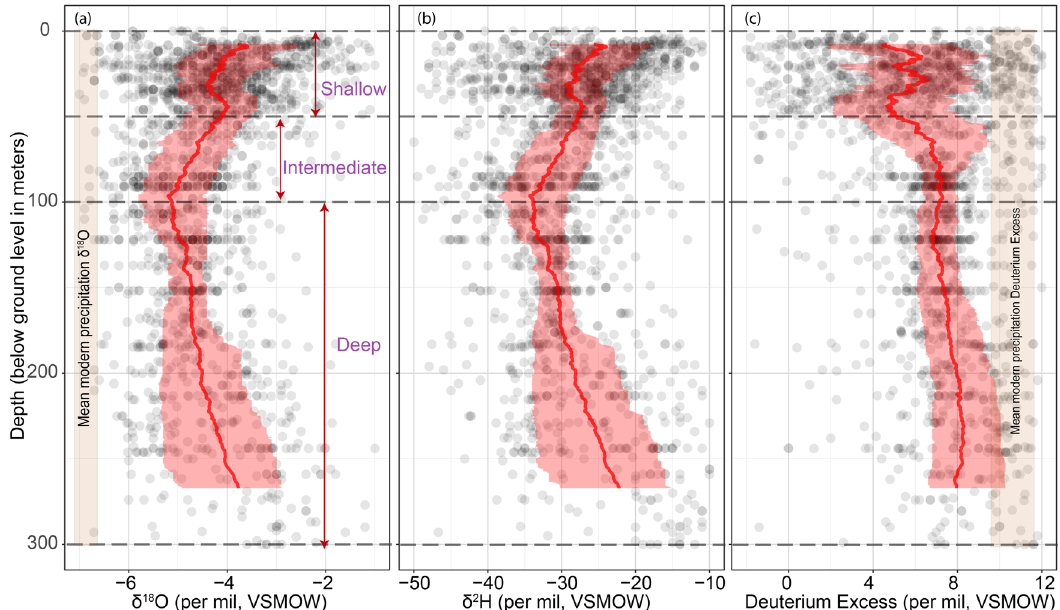
Fig. 6 Depth plot versus groundwater isotope ratios. ( a ) δ 18 O, ( b ) δ 2 H, and ( c ) d-excess. The red line and the light red shaded region are the moving depth average and the interquartile range of 200 groundwater samples starting from 0-m depth. The black circles in panels ( a – c ) are the groundwater δ 18 O, δ 2 H, and deuterium-Excess values. The light brown rectangles in (a) and (c) are the mean modern precipitation δ 18 O and d-excess resepctively.